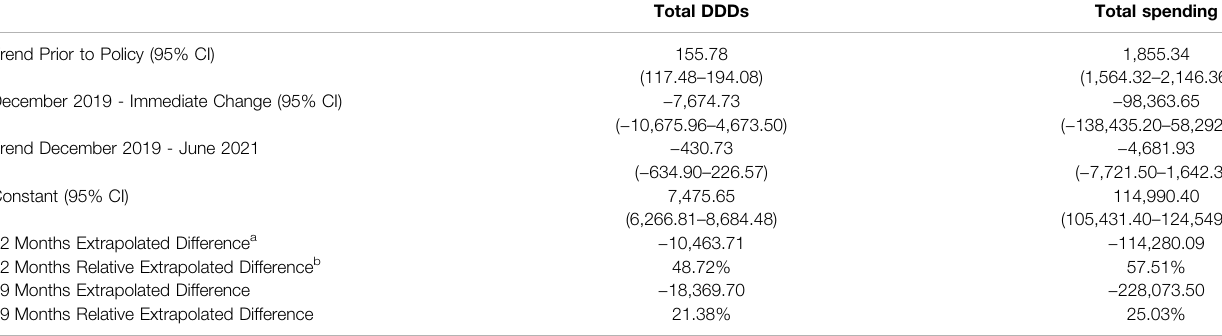
TABLE 2 | Interrupted Time Series analyses for total DDDs and total spending.